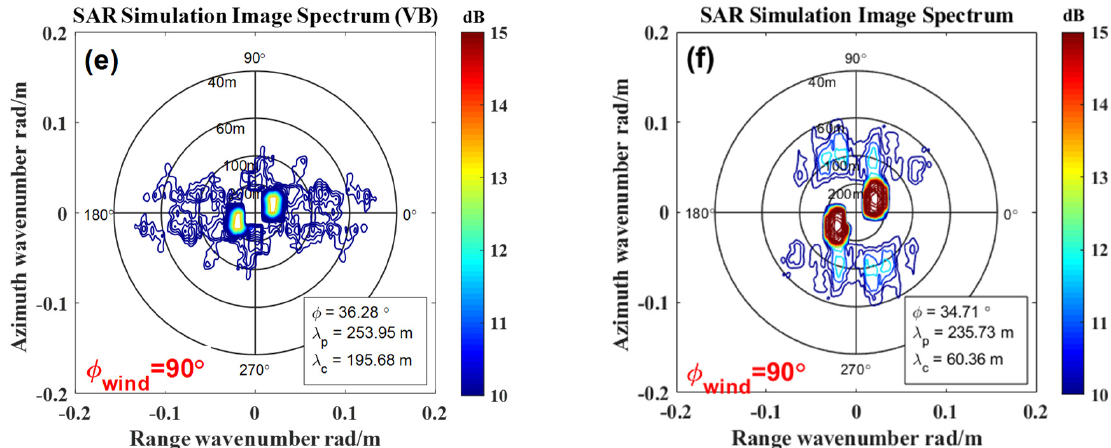
Figure 11. The SAR image spectra corresponding to the SAR images in the Figure 10.